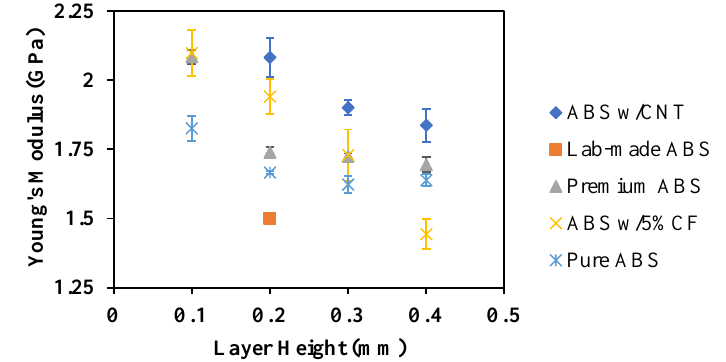
Figure 14. Young’s Modulus of ABS materials as a function of layer height.